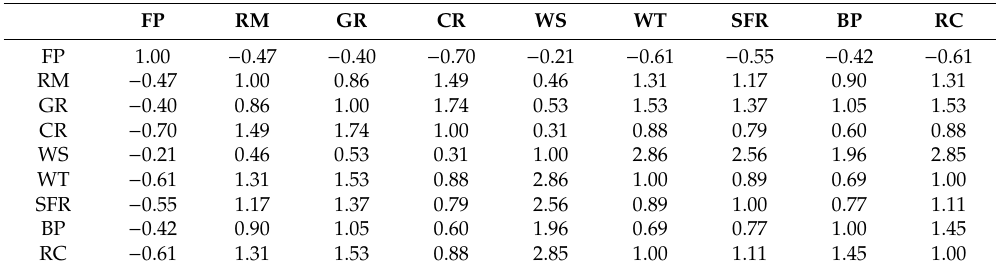
Table 10. Ecosystem services trade-o ff degrees in Jiangxi province from 2000 to